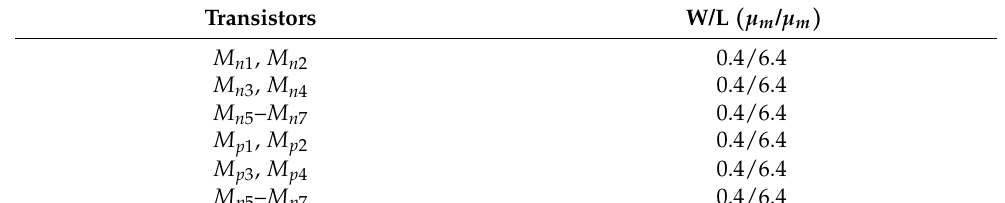
Figure 9. The adjuster circuit is presented. This circuit performs the non-linear minimum and maximum operations and also performs iterations based on mathematical equations, forming a feedback loop to update the current values. Table 4. Adjuster’s MOS transistor dimensions.